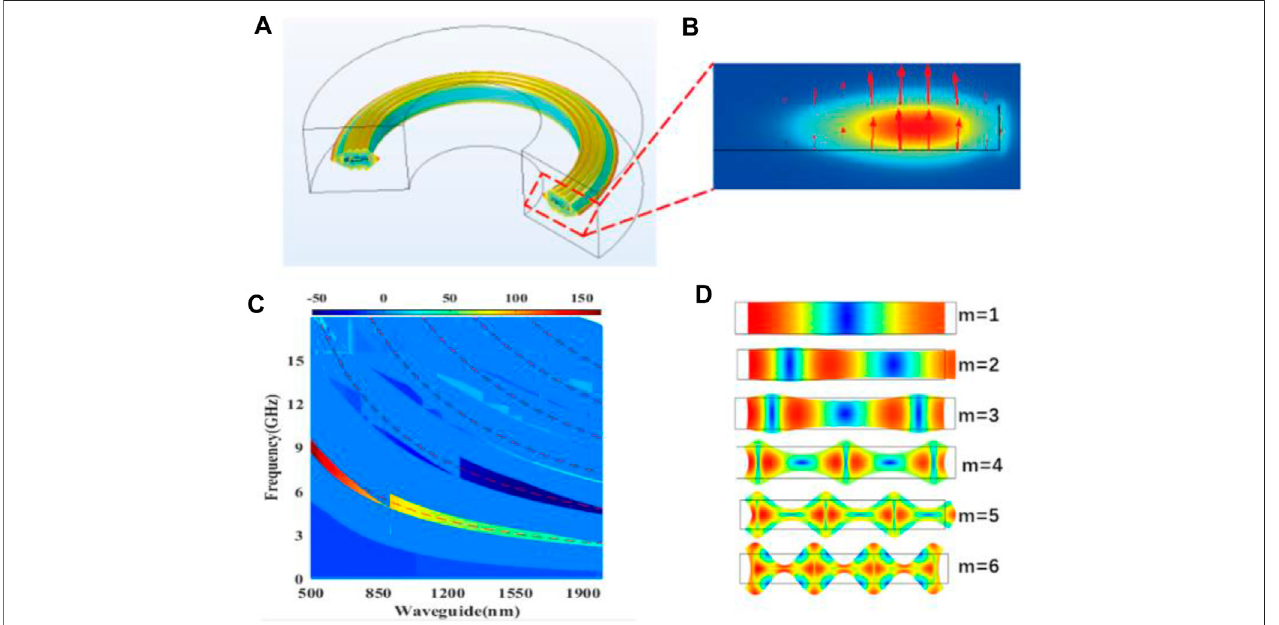
FIGURE2|(A) Amodelofphoto-acousticinteractioninanannularcavity,inwhichthethickness ofthesiliconlayeris250 nmandtheradius oftheannularcavityis 10 μ m. (B) Theelectric fi elddistribution ofthepump lightwhenthewidthis w (cid:1) 1,750 nm. (C) The fi niteelementsimulation ofthechangeofthephoto-acousticcoupling rate withthe section width in theannularcavity structure, and the red dotted lineisthe frequency calculatedaccording tothemulti-ordermode ofFabry Perot. (D) When thewidth is1,750 nm,thepattern distribution ofeach submode(reddot) thatsatis fi esthephasematchingdetermined in c isshown.Eachmode ( m (cid:1) 1,2,...,6)is marked according to the pattern index c